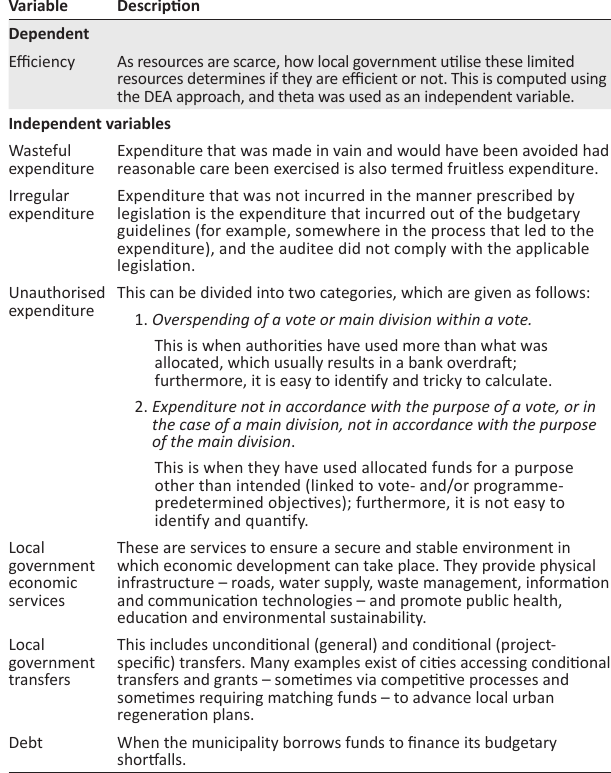
TABLE 2: Variables in the regression equation: drivers of efficiency.